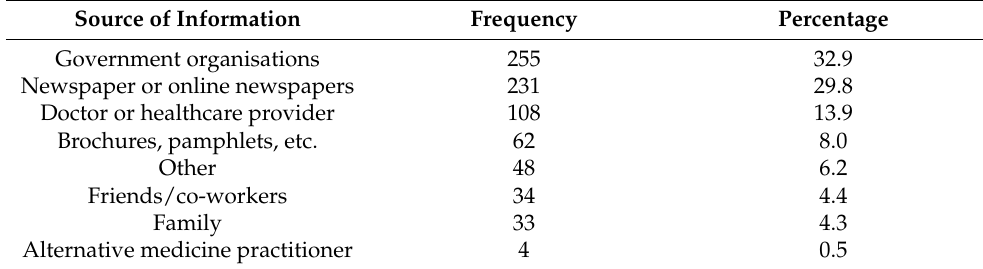
Table 2. Primary sources of COVID-19 information.